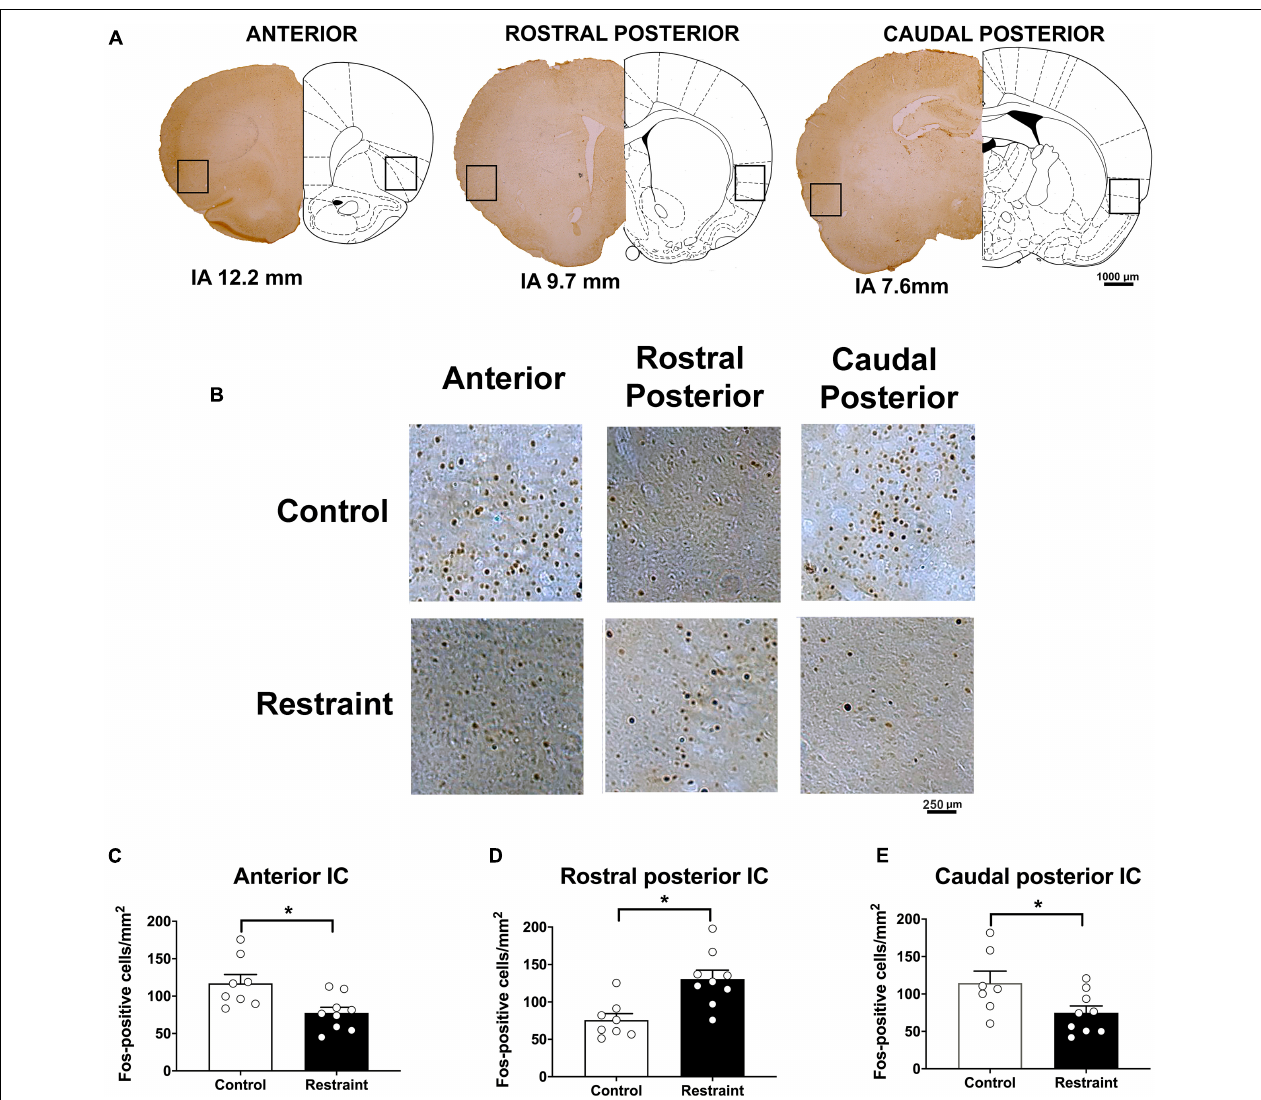
FIGURE 2 | Effect of restraint stress on the number of Fos-positive cells along the rostrocaudal axis of the insular cortex (IC) (A) . Representative coronal sections indicating the IC locations where the Fos-positive cells were quantified (B) . Representative coronal sections showing Fos-positive cells of representative animals in the anterior (left), rostral posterior (middle), and caudal posterior (right) subregions of the IC in control animals (top) and rats subjected to an acute 60-min session of restraint stress (bottom). (C–E) Number of Fos-positive cells in the anterior (C) , rostral posterior (D) , and caudal posterior (E) regions of the IC in control animals (white bars, n = 8) and rats subjected to an acute 60-min session of restraint stress (black bars, n = 9). The bars represent the mean ± SEM. * p < 0.05, Student’s t -test.